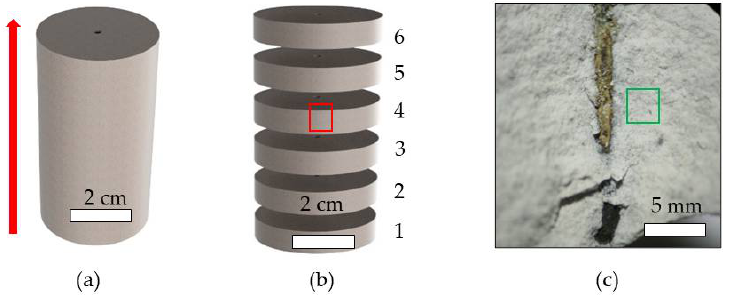
Figure 2. ( a ) The chalk sample (OBSV 12.4) before testing with the location of the drilled fracture (diameter: 2.25 ± 0.05 mm). The red arrow indicates the flooding direction. ( b ) The core was sliced after flooding, where number one is the “inlet”, where the fluids were injected, and the “outlet” is number six. The red square in slice four shows the exact sample location for this study. ( c ) Optical microscopy image of the fracture fill from the sampling area after flooding of the sample. HIM-SIMS analysis was performed from sample material (green square) extracted from the matrix very close to the fracture fill.